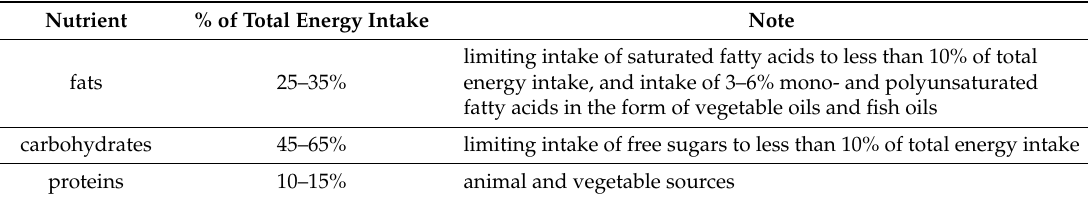
Table 1. Diet composition according to healthy nutrition recommendations of the Polish National Food and Nutrition Institute (Polish acronym I ˙Z ˙Z) and World Health Organization